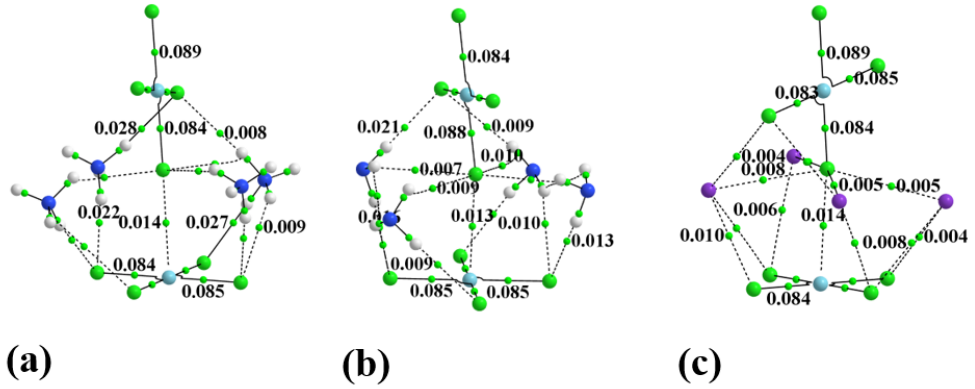
Figure 4. The AIM diagram of dianion surrounded by ( a ) 4 NH 4+ , ( b ) 4 NH 3 , and ( c ) 4 K +. Table 2. AIM properties of bond critical points between subunits in complexes.